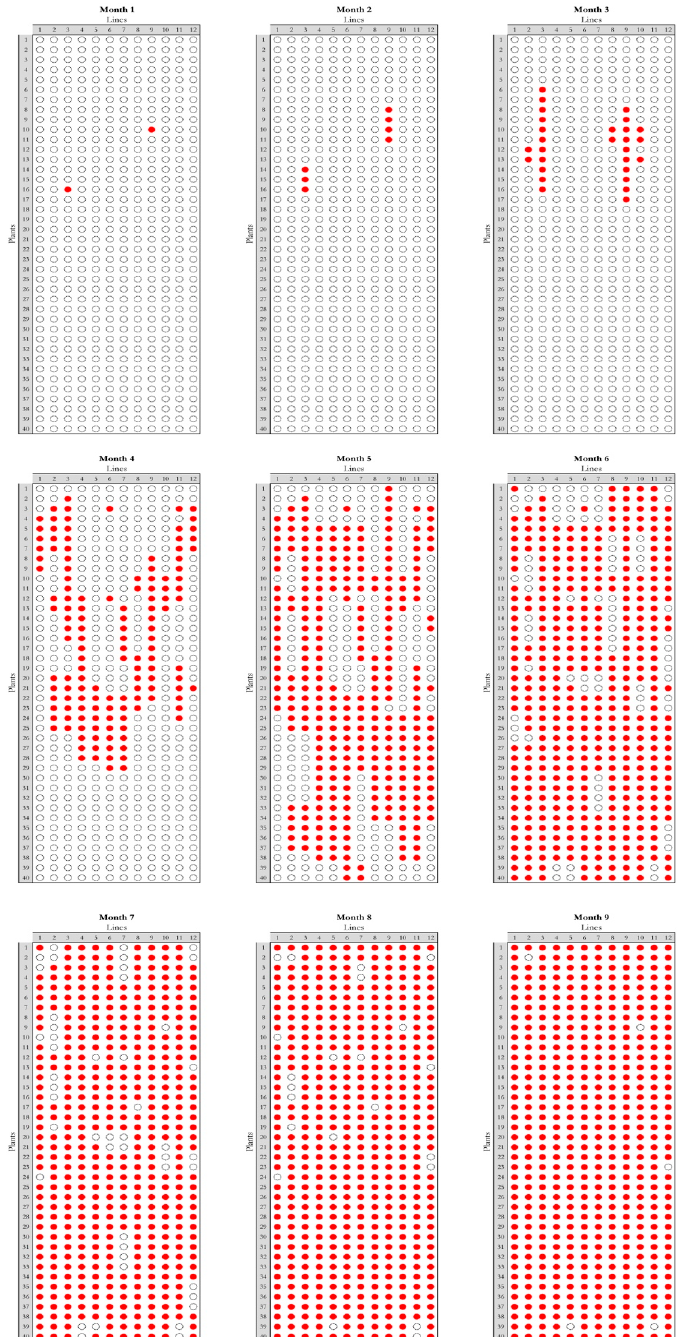
Figure 5. Visualization of ToBRFV spreading in a greenhouse during the nine-month monitoring, starting from two ToBRFV infected plants and two bumblebees hives. Red dots represent the infected plants; white dots represent healthy plants.